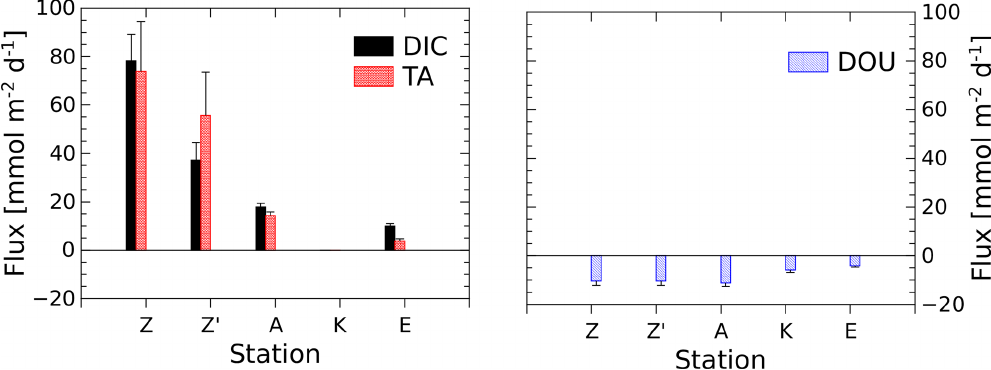
Figure 3. DIC and TA fluxes measured with the benthic chamber and diffusive oxygen uptake (DOU) rates calculated from in situ micro- electrode depth profiles at stations A, Z (measured during two deployments) and E. Error bars represent either uncertainties about the linear regression of the benthic DIC and TA gradients, taking into account individual error bars of each data point, or error propagation and standard deviations of multiple DOU measurements. Fluxes out of the sediment are positive and fluxes into the sediment are